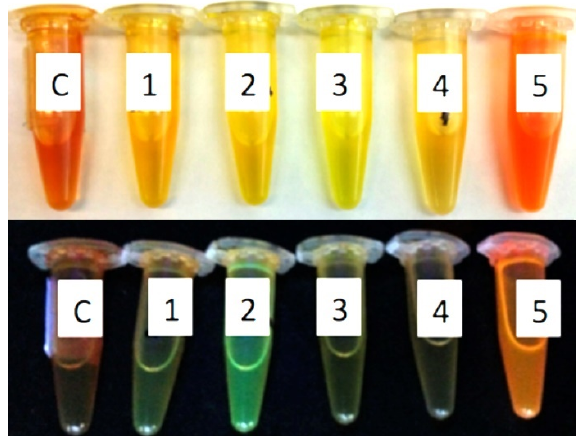
Figure 3. Emission observed for curcumin derivatives under visible light ( top ) and ultraviolet light ( bottom ). The figure illustrates the bright emission of 2 and 5 under ultraviolet light. C, curcumin.